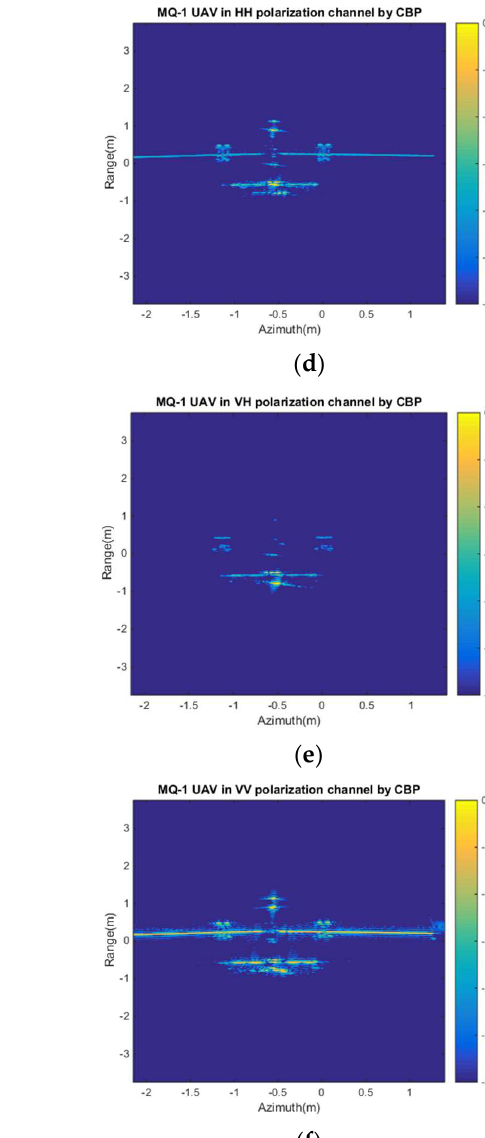
Figure 5. The full-polarization imaging results of the “Frontier” UAV with the FFT and CBP algorithm ( a ) “Frontier” in HH polarization by FFT; ( b ) “Frontier” in HV polarization by FFT; ( c ) “Frontier” in VV polarization by FFT; ( d ) “Frontier” in HH polarization by CBP; ( e ) “Frontier” in HV polarization by CBP; ( f ) “Frontier” in VV polarization by CBP.